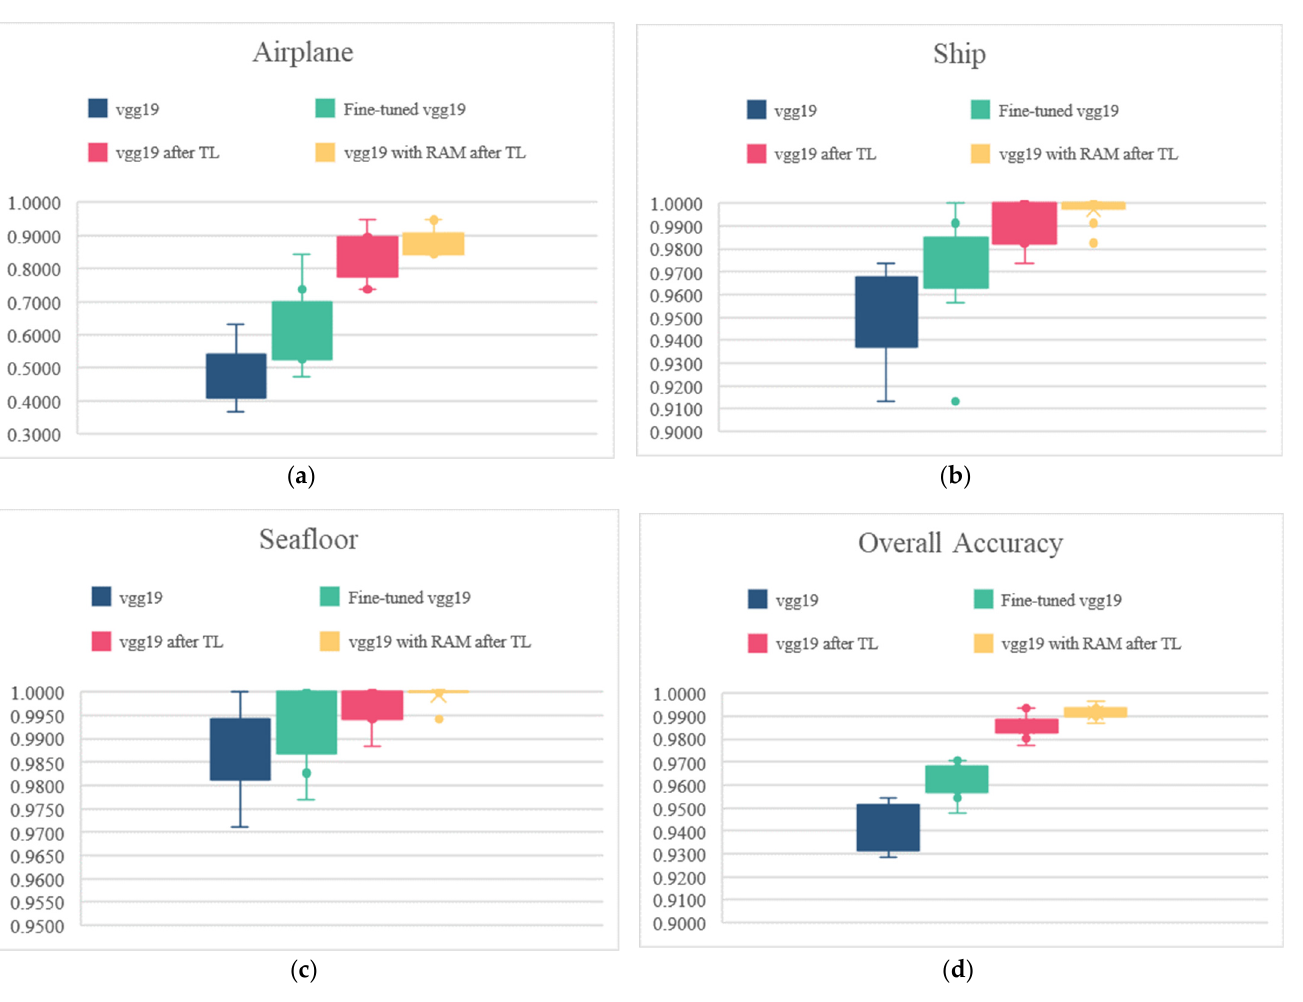
( c ) Figure 10. Feature response maps and that after staining: ( a ) Feature maps of the first 16 channels of the first convolution layer; ( b ) The superimposition map of feature maps of all channel responses; ( c ) The stain chart of ( b ).